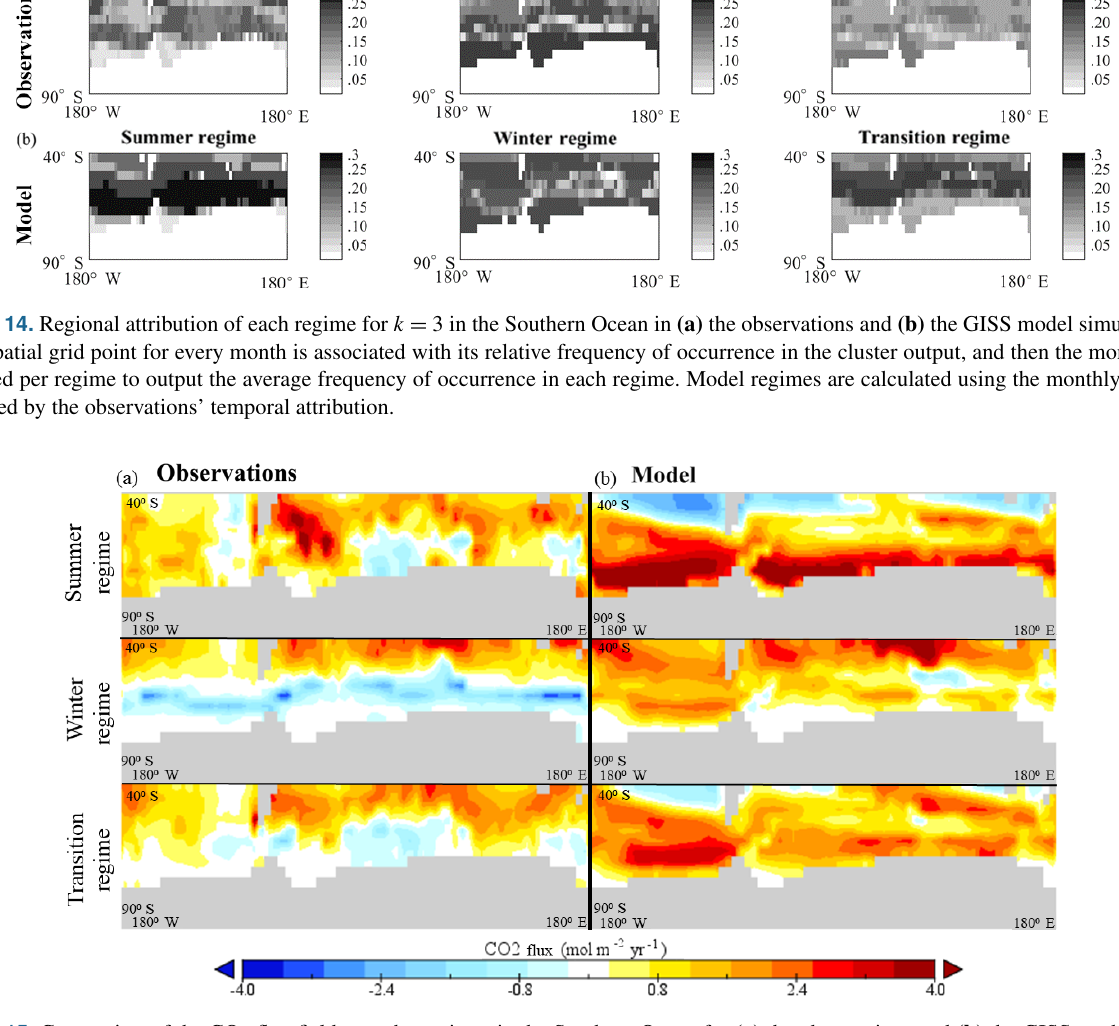
Figure 15. Composites of the CO 2 flux field over the regimes in the Southern Ocean for (a) the observations and (b) the GISS model. Both the observations and the model data are composited over the same months as determined by the temporal attribution of the observed regimes. Blue shades indicate outgassing, and red shades indicate